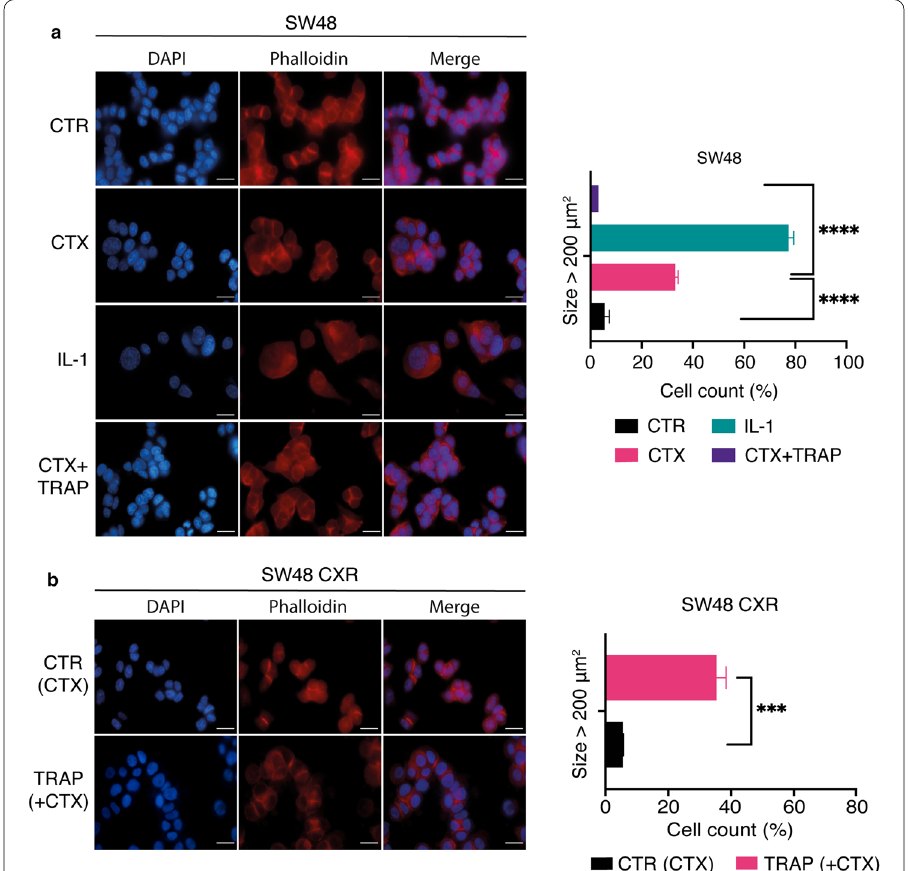
Fig. 2 TRAP IL-1 inhibits CTX-induced gigantism while stimulating senescence morphology in SW48-CXR. SW48 and SW48 CXR cell lines (4 10 4 cells per well) were seeded on 13 mm coverslip. After 24 h, SW48 × cells were treated for 4 days with control medium (10% FBS), IL-1 (α and β, 10 ng/ml each), and CTX (50 μg/ ml) alone and in combination with TRAP IL-1 (20 μg/ml). SW48 CXR cells were treated with control medium (10% FBS CTX 50 μg/ml), and TRAP IL-1 (20 μg/ml). Subsequently, they were fixed and stained with DAPI + (nuclei) and phalloidin (TRITCH) for 30 min. Finally, coverslips were mounted on slides and examined with